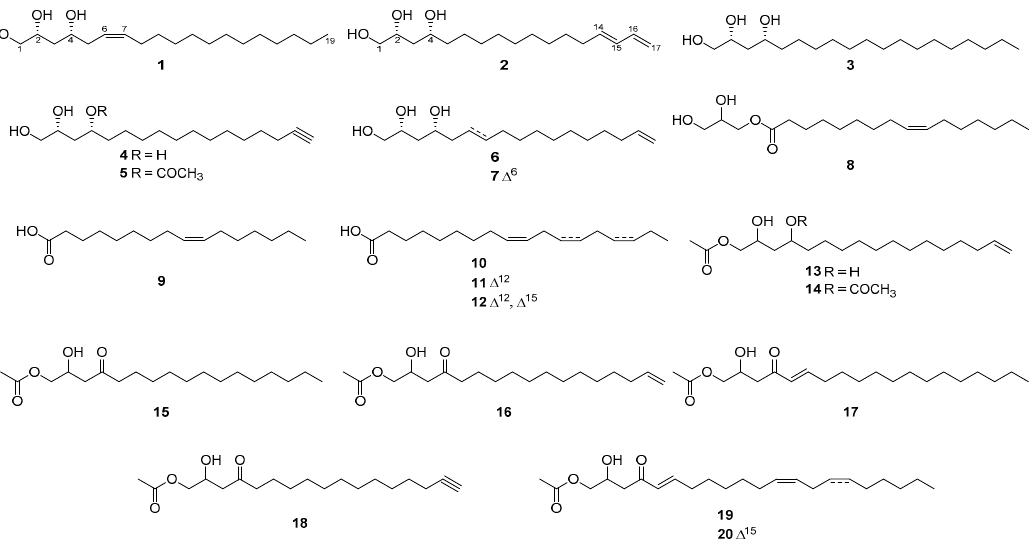
Figure 2. Chemical structures of compounds 1 – 20 .